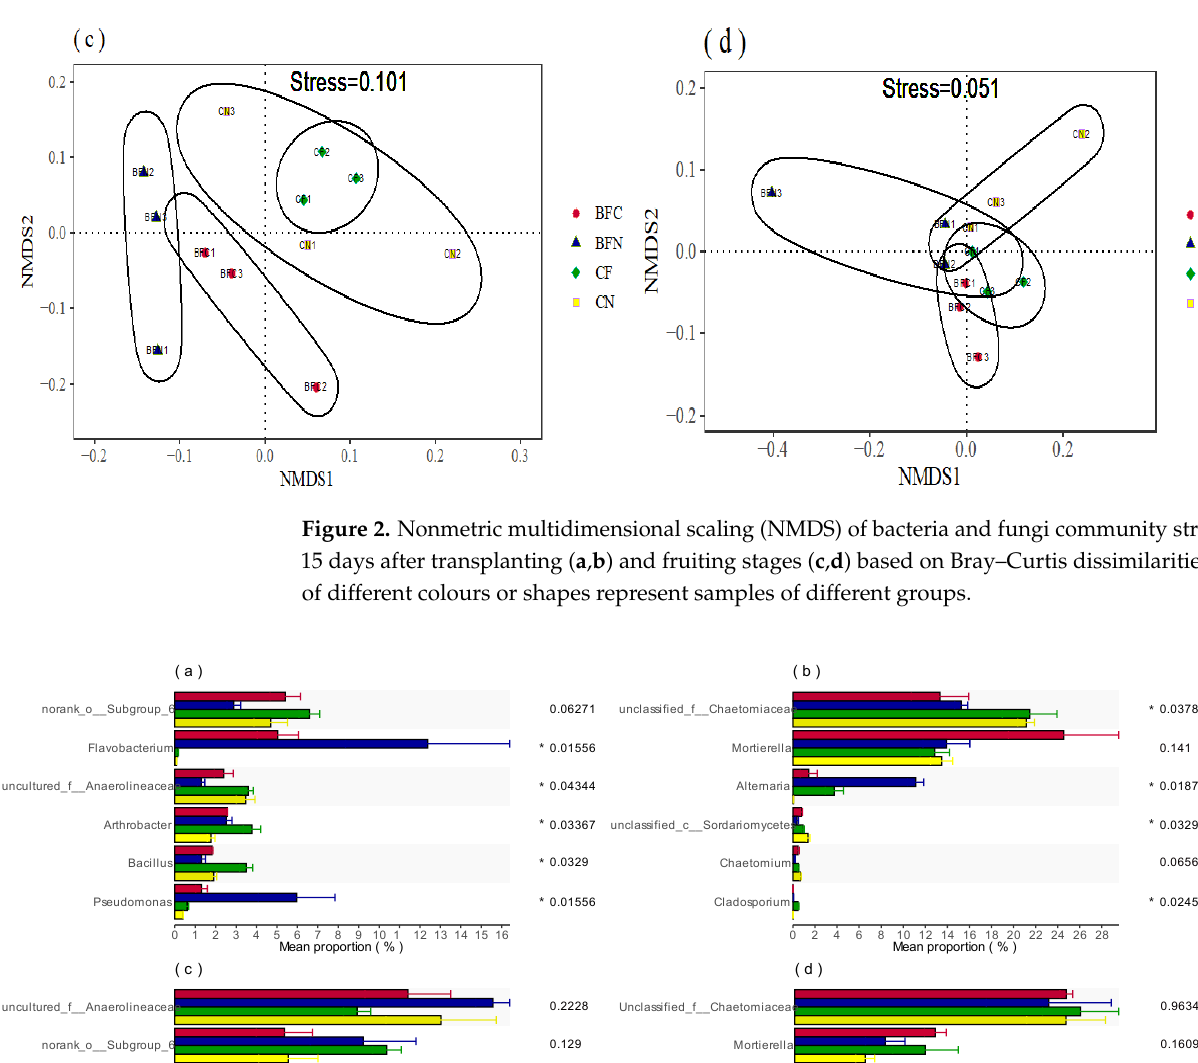
FlavobacteriumPseudomonasBacillusArthrobacternorank_o__Subgroup_6uncultured_f__Anaerolineaceae